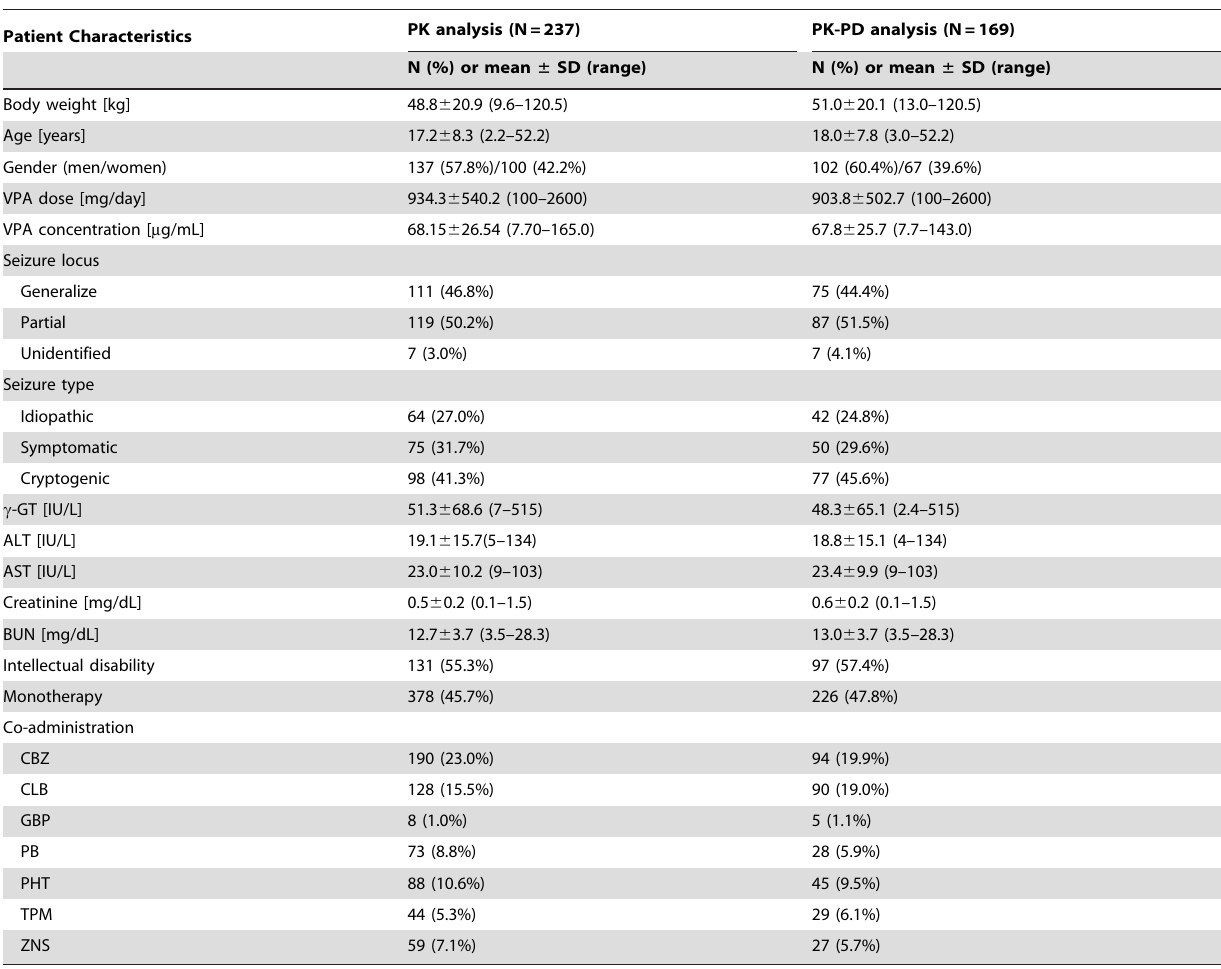
Table 1. A summary of the patient